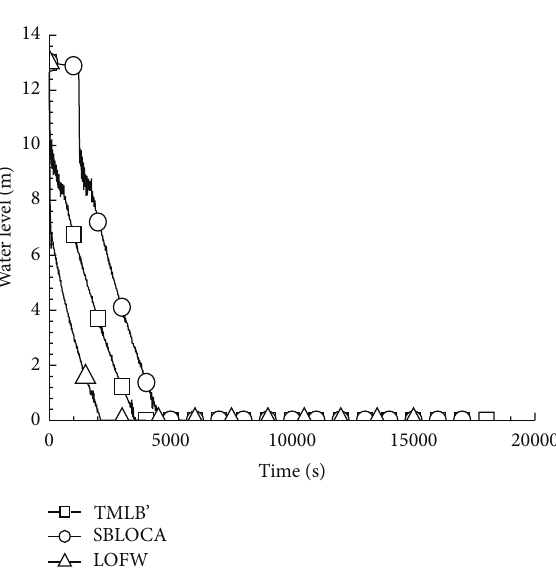
Figure 3: Secondary water level of SG without activation of SADV.